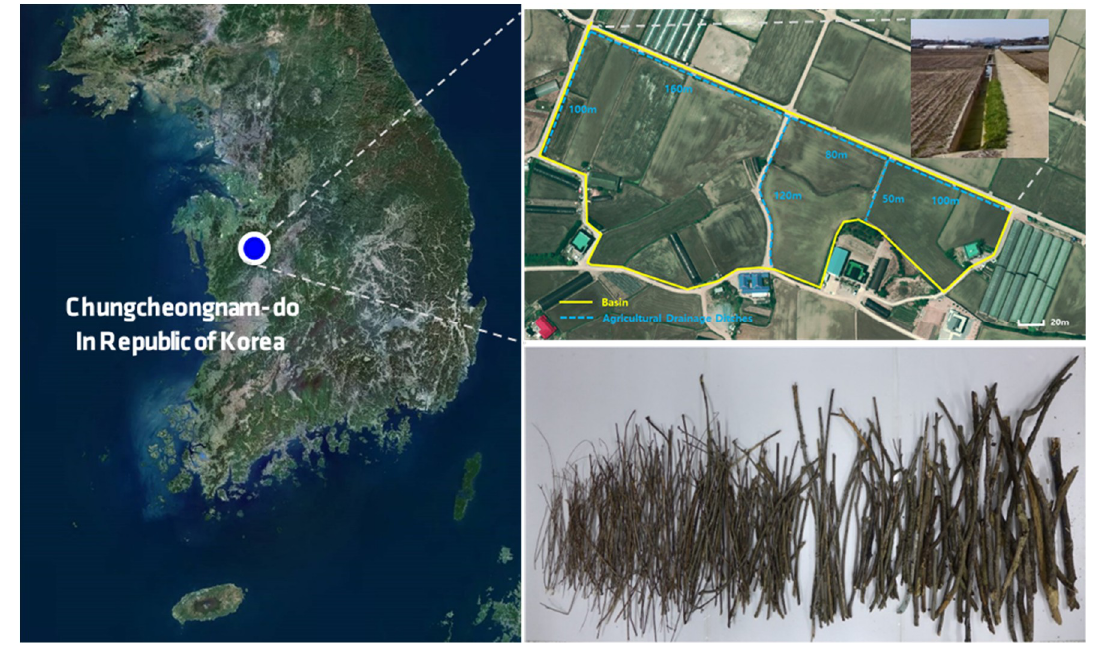
Figure 2. Driftwood found near agricultural drainage ditches.